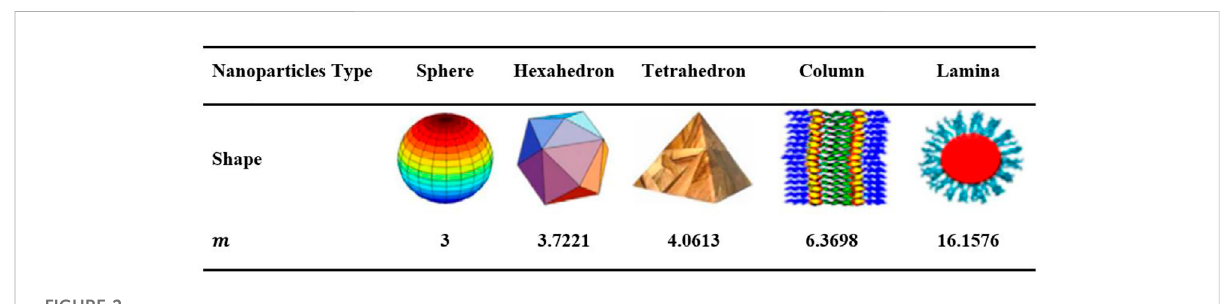
FIGURE 2 Standards of the practical shaped element for diverse particle shaped. The material possessions of the crucial sodium alginate (C 6 H 9 NaO 7 ) and the various NP exploited in this research are indicated in Figure 3 (Xu and Chen, 2017; Makinde et al., 2018; Jamshed et al., 2021d).